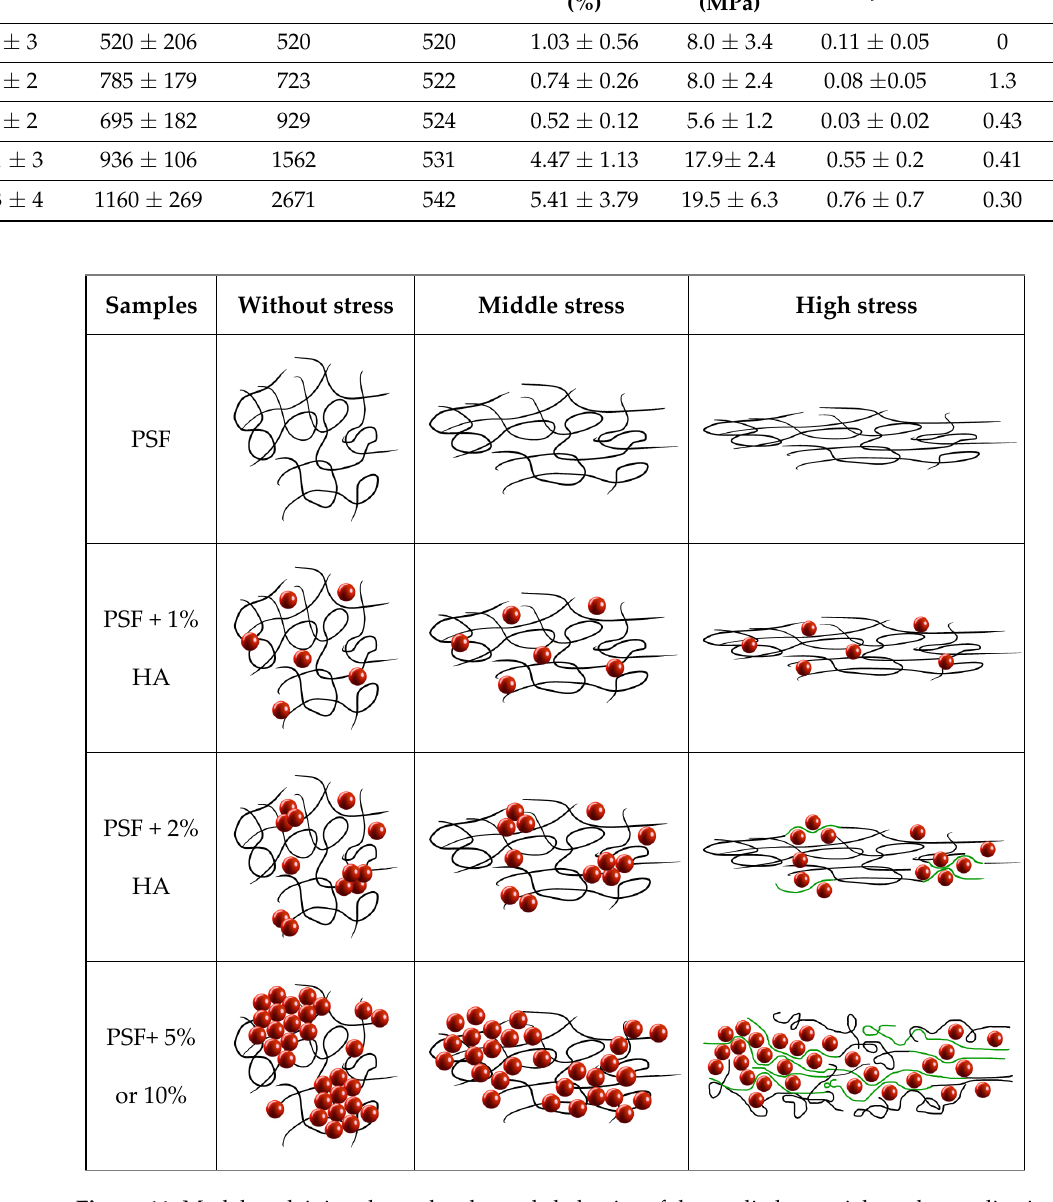
Figure 11. Model explaining the molecular scale behavior of the studied materials under application of uniaxial loads in a tensile test (green lines account for macromolecular portions which conformations are forced to change when nanoparticles rolled away during disaggregation of agglomerates).